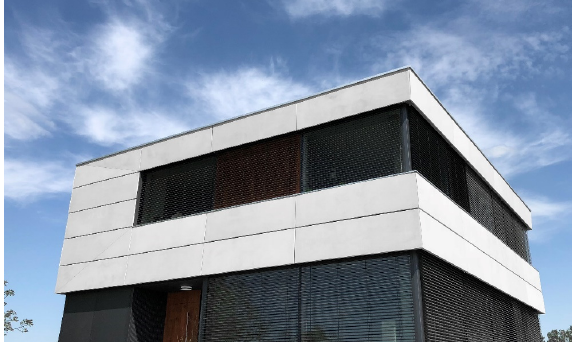
Figure 2. Carbon reinf. concrete façade white con- crete - curtain